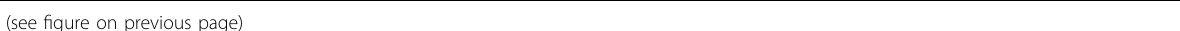
Fig. 3 MMN response in rats after PCP withdrawal. a Grand average-evoked potentials elicited during auditory passive oddball stimulation fl ip- fl op protocol. Changes on standards and deviants ’ stimuli (standard tones of 8 kHz presented at 90% probability; deviant tones of 6 kHz presented at 10% probability) at baseline (i.e., prior subchronic treatment) in all animals ( n = 23, blue dot line), animals from the PCP ( n = 13, red dash line), or vehicle ( n = 10, black continuous line) and 7 days after PCP ( n = 12, red continuous line) or vehicle ( n = 8, black continuous line) treatment discontinuation. The upper and lower panels illustrate ERPs recorded via Channel#1 and Channel#2, respectively. The results are expressed as means. BL baseline. b The left panel illustrates MMN area (calculated with the 6-kHz fl ip- fl op method) expressed in change from baseline (CBL) with EEG recording on Channel#1 ( n = 8 – 12). An unpaired Student ’ s t test revealed signi fi cant impairment in PCP-treated rats compared to control ( t 18 = 2.496; * P = 0.0225). Individual data are represented along with means ± SEM. The right panel shows MMN area expressed in change from baseline (CBL) with EEG recording on Channel#2 ( n = 8 – 12). An unpaired Student ’ s t test revealed no signi fi cant impairment in PCP-treated rats compared to control ( t 18 = 1.145; P = 0.2671). Individual data are represented along with means ± SEM. c Delta tN – tF in the NOR assay ( n = 11 – 14). An unpaired Student ’ s t test revealed signi fi cant impairment in PCP-treated rats compared to control ( t 23 = 4.007; *** P = 0.0006). The results are expressed as means ± SEM. d General locomotor activity (number of photobeam breaks, n = 11 – 14). No signi fi cant effect of the subchronic PCP treatment was observed in the 10-min binning ( F 1,25 = 0.1734; P = 0.681 for treatment effect with two-way ANOVA) or the 120-min ( t 25 = 0.416; P = 0.681 with unpaired Student t-test) analyses. The results are expressed as means ±